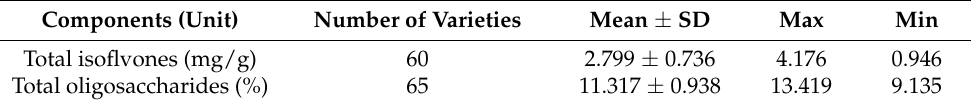
Table 4. Statistical data of the targeted components for testing model. Components (Unit)